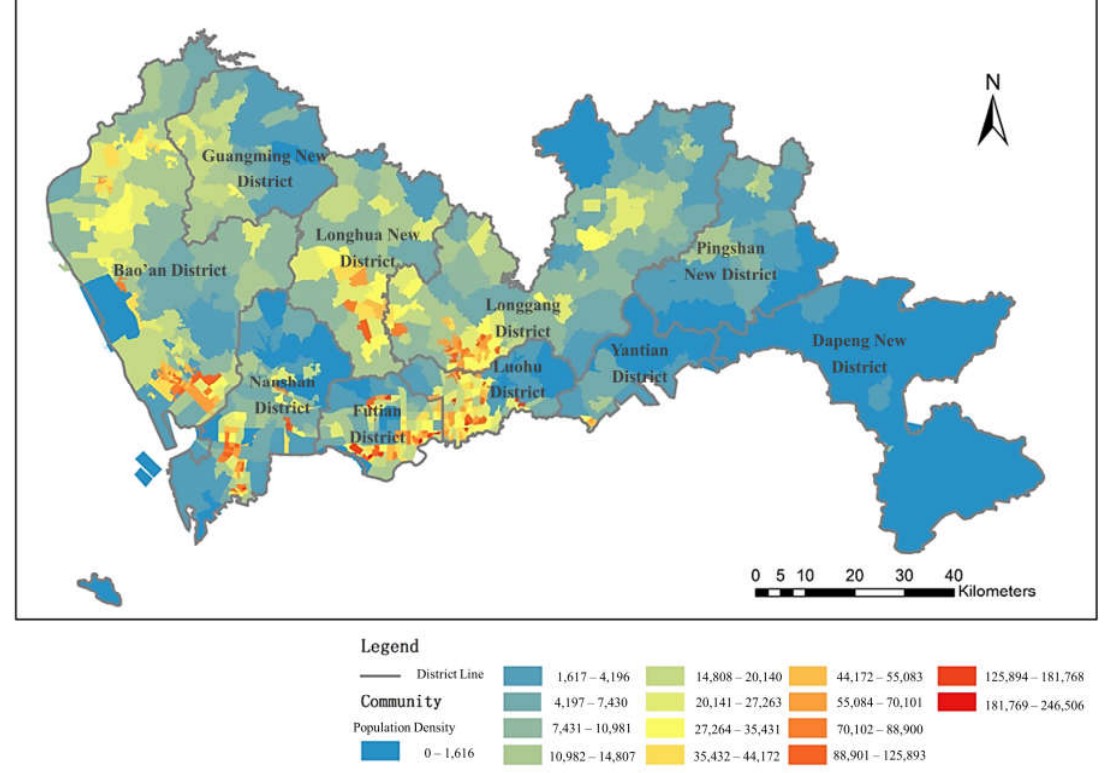
Figure 2. Distribution of population density in Shenzhen.